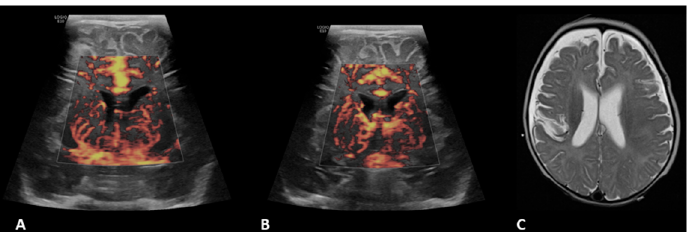
Figure 5. A 4-month-old boy with a history of complete common atrioventricular canal underwent ECMO due to failure to wean from cardiovascular bypass after major cardiac surgery. Brain MVI was performed after five days from cannulation; grayscale US (not shown) demonstrated extra-axial collections. Coronal brain MVI ( A , B ) demonstrated marked cortical white matter vascular engorgement and heterogeneity. MRI obtained three months after ECMO decannulation showed a moderate, late subacute to chronic infarct in the right parietotemporal cortex ( C